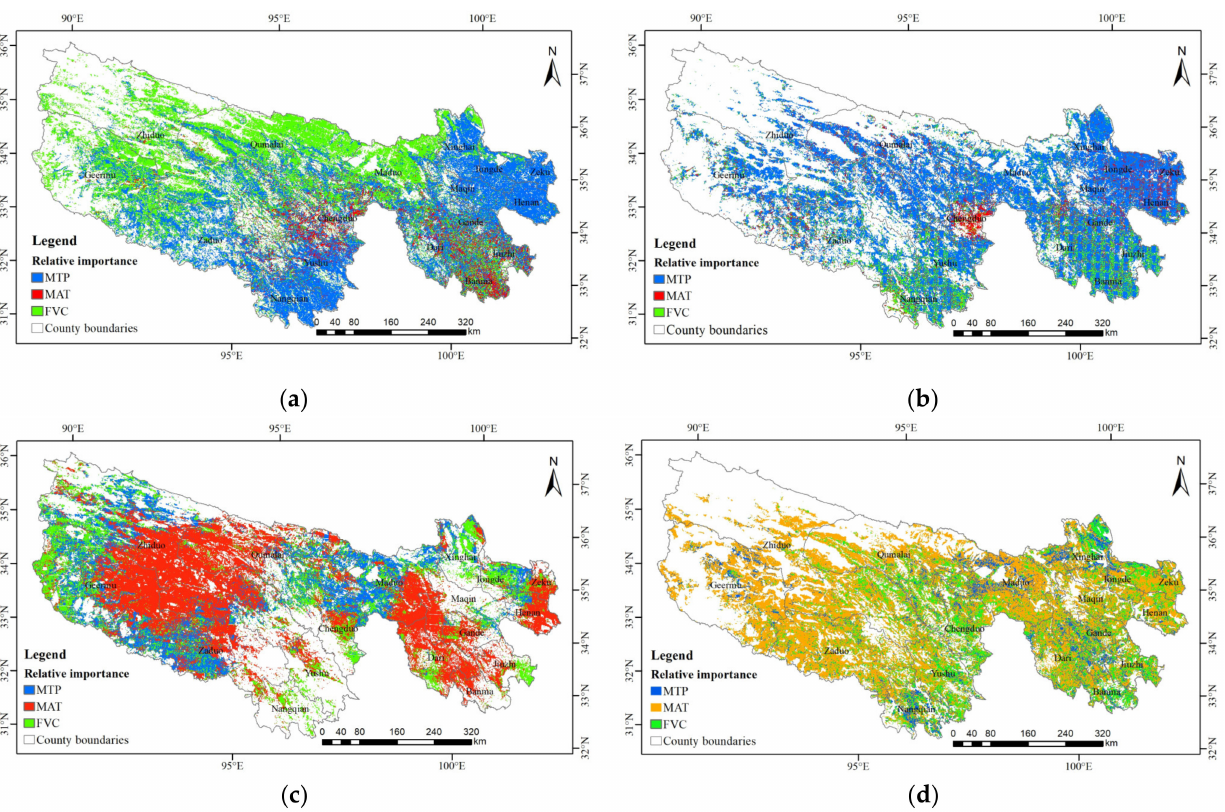
Figure 11. Relative importance of influencing factors to water retention ( a ), soil retention ( b ), sand retention ( c ), and grass yield ( d ) services in the